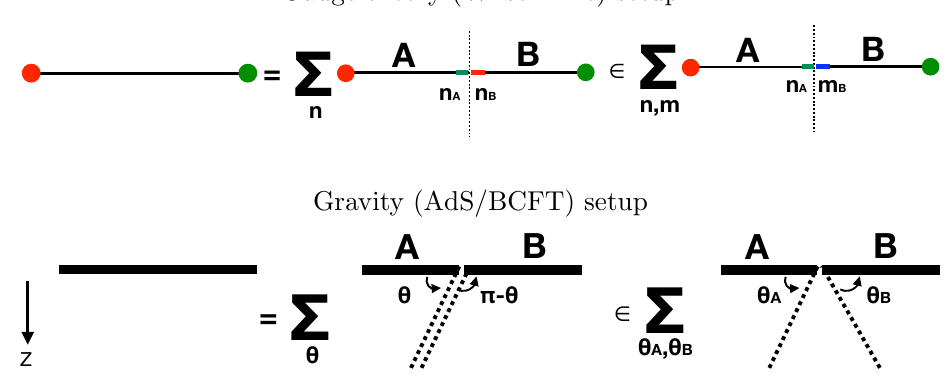
Figure 10 . Schematic pictures on embedding the physical states into the extended Hilbert space includes all gauge-variant states in gauge theories and gravity